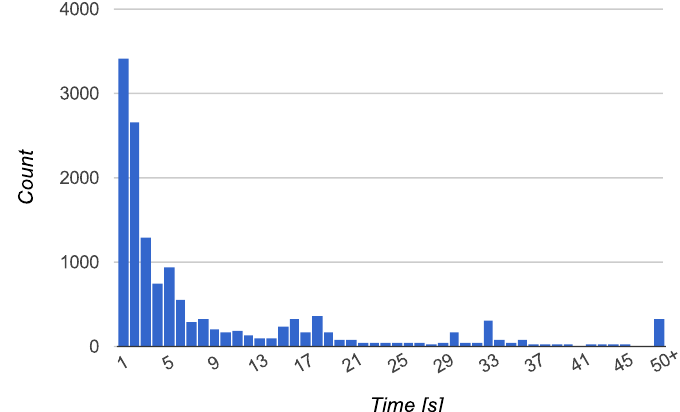
Figure 9. Time of GPS activity before providing a position fix or being disabled due to poor signal. Random 5% sample from 272,000 measurements on 44 unique user